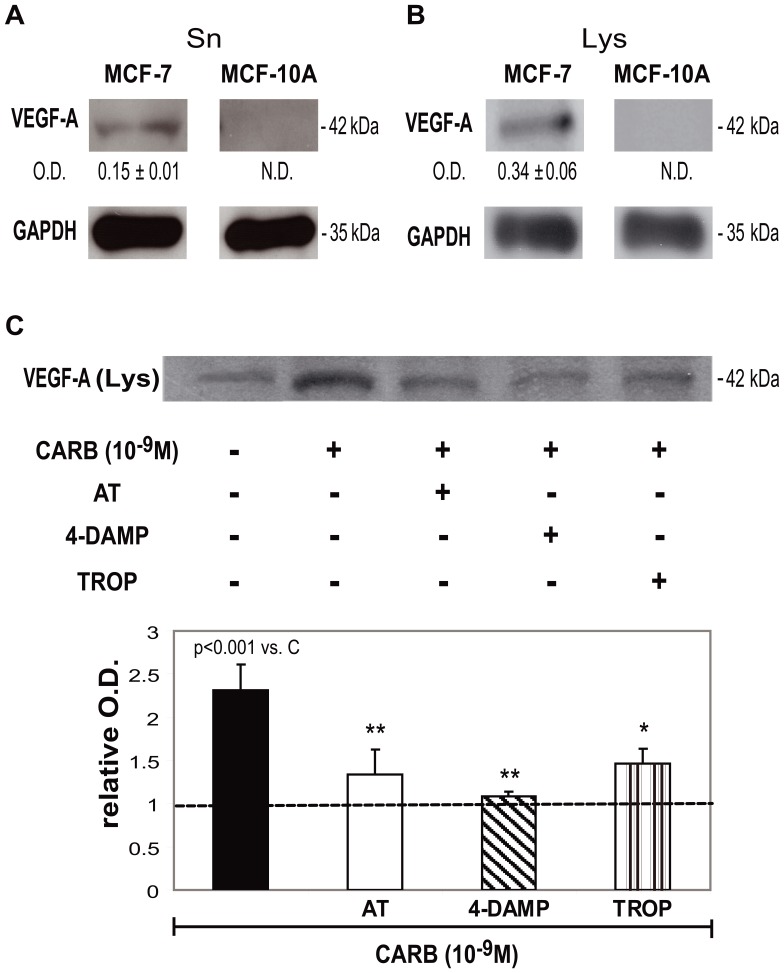
Effect of carbachol on VEGF-A expression in MCF-7 cells.Western blot assays were performed in A) supernatants (Sn) and B) lysates (Lys) from MCF-7 and MCF-10A cells. Optical density (O.D.) of the bands was calculated by densitometric analysis, and values were relativized to the expression of glyceraldehyde-3-phosphate dehydrogenase (GAPDH). N. D. not detectable. One representative experiment of three is shown. Values are mean ± S.E.M. of three experiments. Molecular weights are indicated on the right. C) MCF-7 cells were treated for 1 h with 10−9 M carbachol (CARB) in the absence or presence of 10−8 M atropine (AT), 4-diphenylacetoxi-N-methylpiperidine (4-DAMP), or tropicamide (TROP) and VEGF-A expression was measured in Lys. Densitometric analysis of the bands is shown in lower panel. Values were relativized to the expression of VEGF-A in MCF-7 cells without treatment, considered as 1, and is represented by a dotted line. Molecular weights are indicated on the right. Values are mean±S.E.M of three experiments. *p<0.1; **p<0.01 vs. CARB.